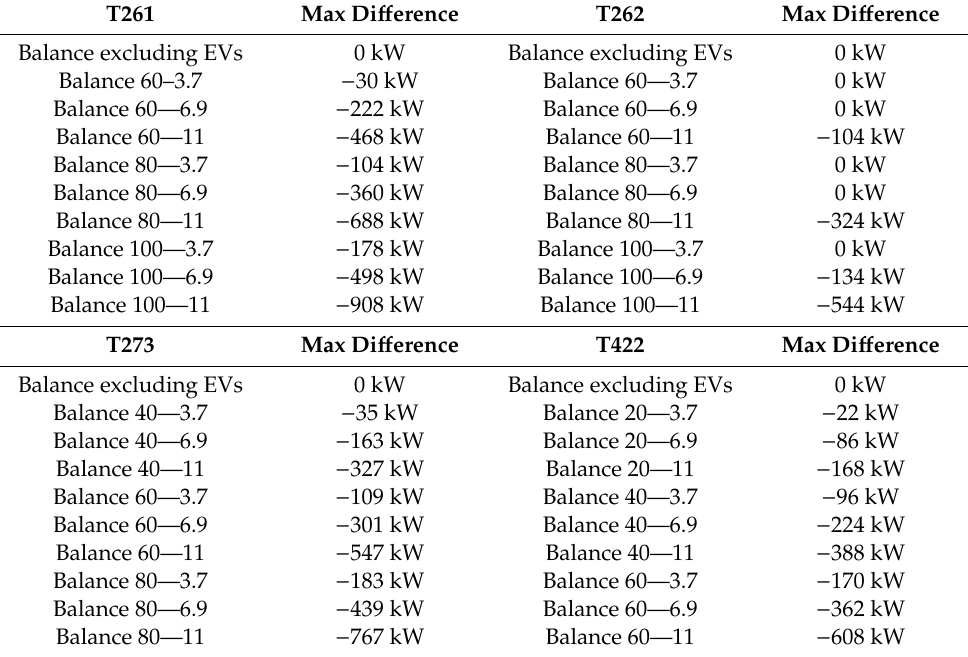
Table 3. Maximum power balance 3.7, 6.9, or 11 kW power—constant